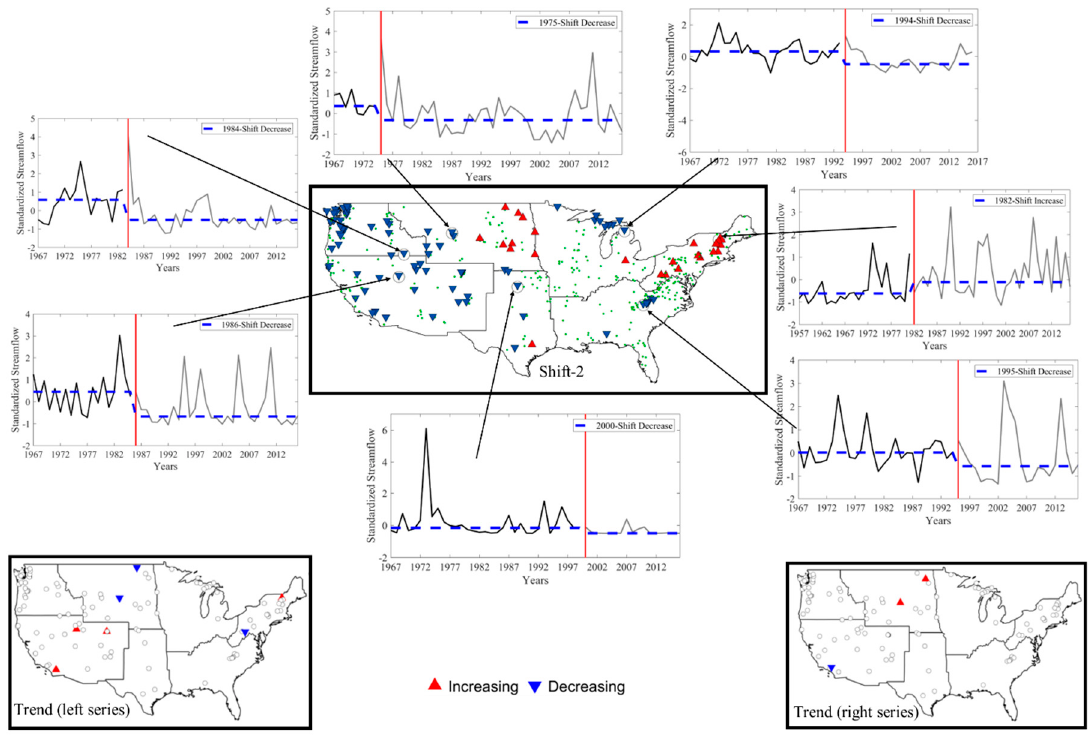
Figure 6. A spatial plot of stations showing significant Shift-2 is shown in the central panel. The spatial plots in the bottom left / right panel represent the trend significance in the left series / right series, respectively. The seven time series plots represent the sample stations of each climate region; the vertical red line represents the change point for each sample station. The dark and grey lines in the time series plots represent the left series and right series, respectively. The dashed blue lines represent the change in median streamflow in the left and right series. All the plots represent summer streamflow volume. The upward / downward triangles represent increasing / decreasing trend and Shift-2 at the statistical significance of p ≤ 0.05.